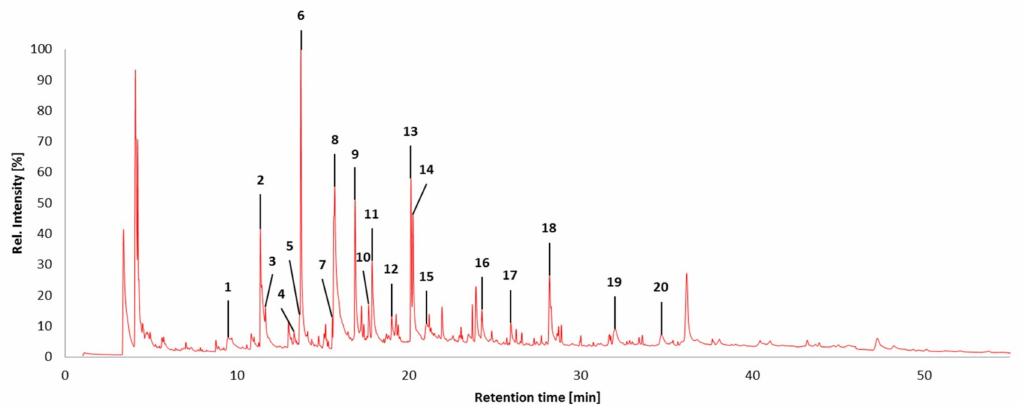
Figure 9. Pyrolysis-GC/MS pyrogram of a lignin obtained from Miscanthus x giganteus Gig17M. Stem/leaf mixture with numbers for all aromatic fragments listed and assigned in Table 6. Table 6. Pyrolysis-GC/MS fragments of the sample Gig17M and assignment to H, G, and S units. Peak